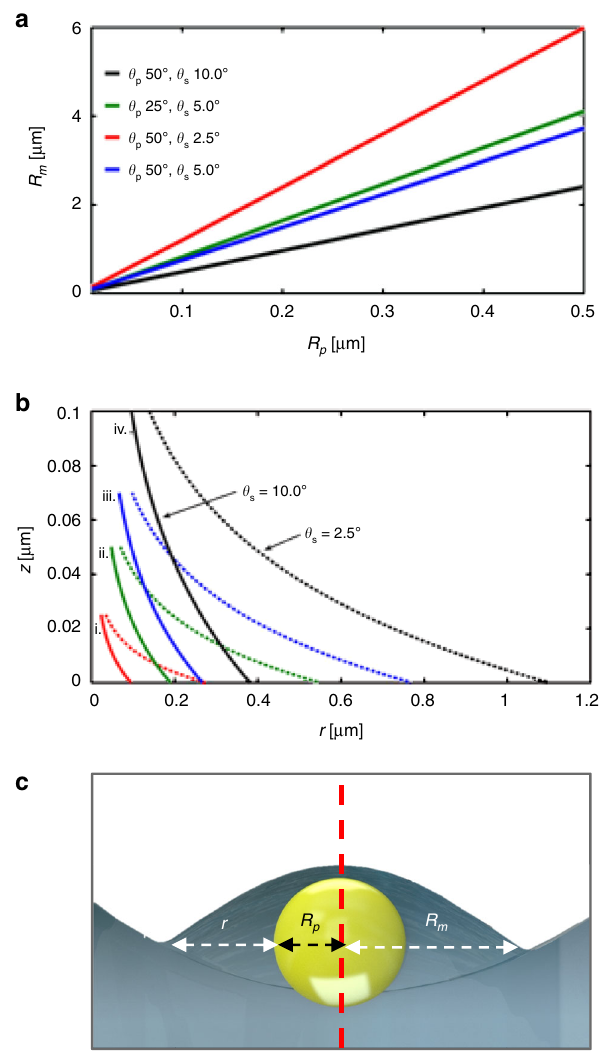
Fig. 7 Parametric analysis of nano-lens curvature for different particle sizes. a Numerical calculations of nanoparticle-nanolens complex radius, R m as a function of particle size R p . Each line represents calculations for different contact angle pairs θ s and θ p . For a 200 nm nanoparticle, the corresponding maximum R m can exceed 2 μ m. b Numerically calculated meniscus radius for (i) 50 nm (red), (ii) 100 nm (green), (iii) 140 nm (blue), and (iv) 200 nm (black) spherical nanoparticles to emulate the nanoparticles used experimentally (also see Supplementary Fig. 1). The unbroken line (-) represents θ s of 10.0° whereas, the broken line (--) represents θ s of 2.5°. For a 200 nm nanoparticle, the corresponding maximum R m can exceed 2 μ m. c Schematic diagram of the nanolens parameters. The red dotted indicates